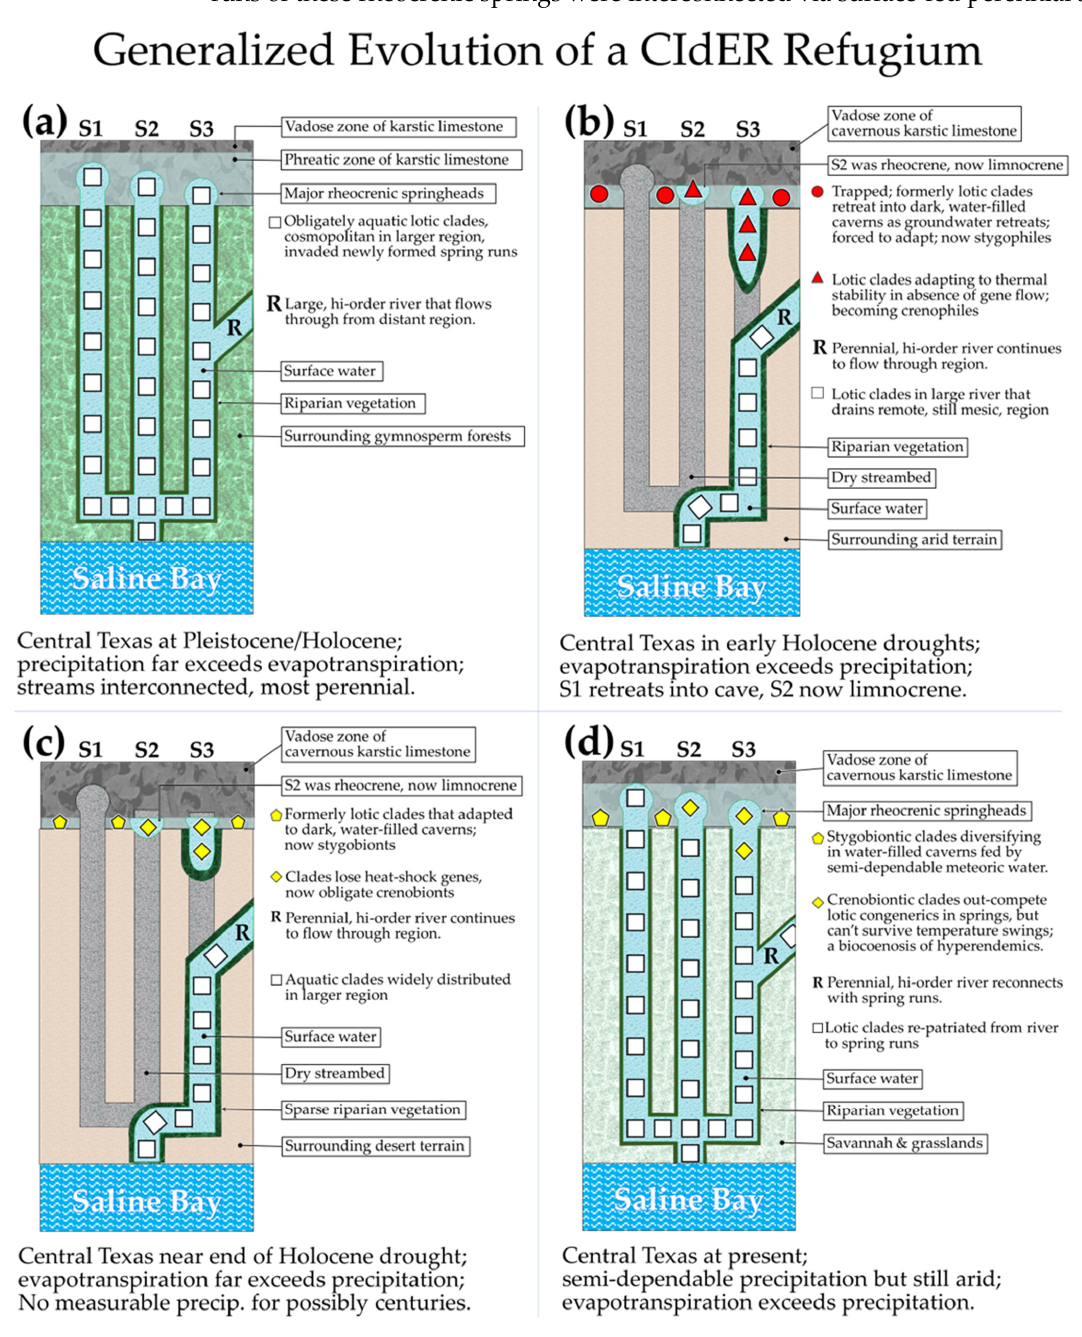
Figure 2. Schematic of the hypothesized sequence of events leading to the development of a CIdER refugium, using Central Texas as an example. S1–S3 represent three springs interconnected under- ground by conduits fed by the same aquifer pool, with S1 opening at the highest elevation and S3 at the lowest elevation of the three. ( a ) Conditions during late Wisconsin Glaciation and early Hol- ocene (ca 20–9 kya) with abundant precipitation well in excess of evapotranspiration, and